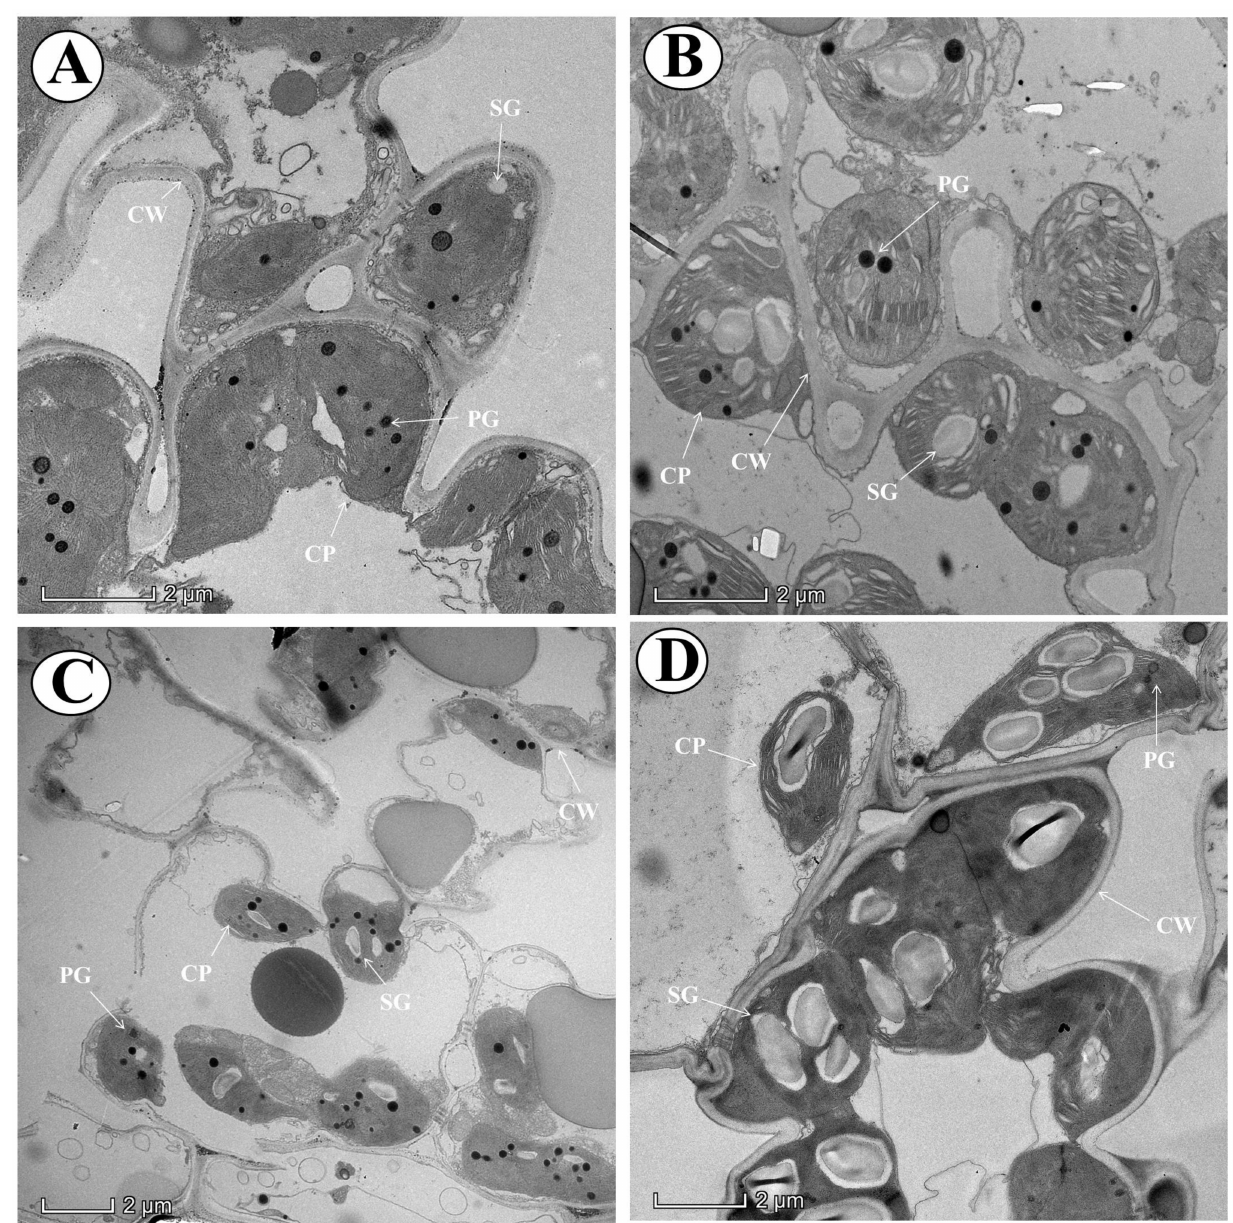
Figure 2. Effect of Mo supply and Cd toxicity on the transmission electron microscopy (TEM) images of aromatic rice ‘Xiangyaxiangzhan’ cultivar. Aromatic rice plants were treated with ( A ) (0 and 0 mg), ( B ) (0.15 and 0 mg), ( C ) (0 and 100 mg), and ( D ) (0.15 and 100 mg) of Mo and Cd, respectively. CP, chloroplasts; PG, plastoglobuli; CW, cell wall; SG, starch